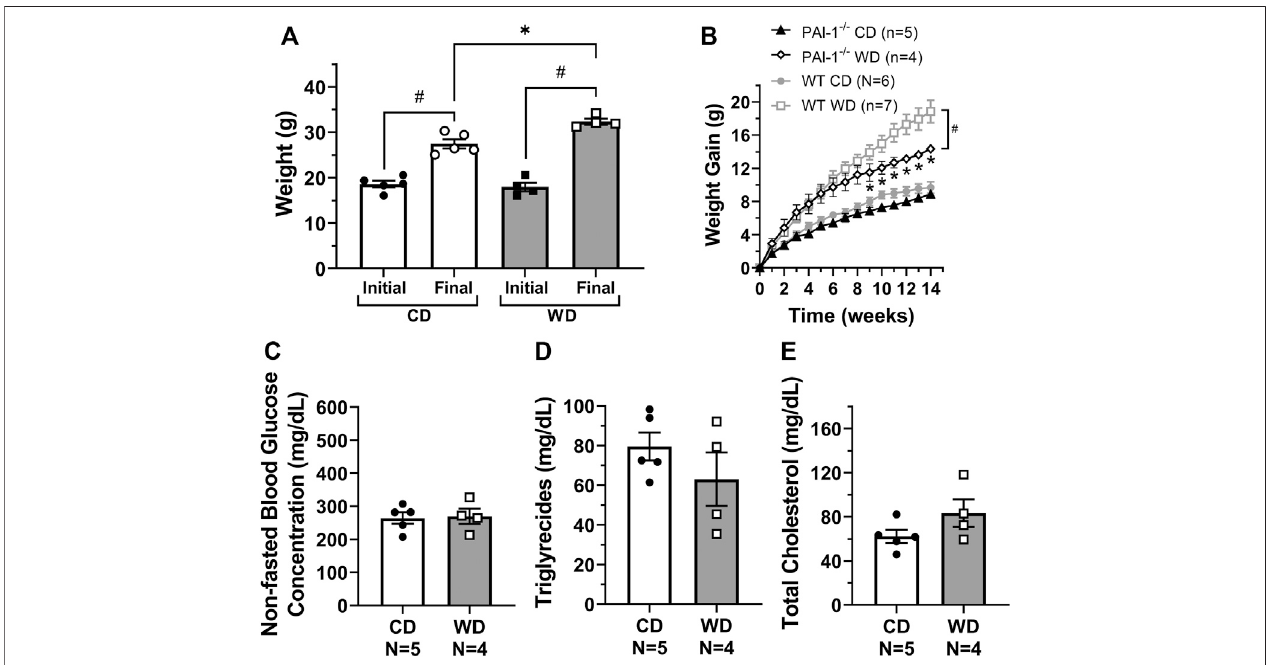
FIGURE 5 | Global PAI-1 de fi cient mice are partially protected against metabolic dysfunction. For PAI-1 − / − mice, (A) initial and fi nal body weight control diet (CD) and western diet (WD) groups; (B) overall gain in body weight per week over the 14-week treatment period (WT data from Figure 1B is also shown in gray); and (C – E) non-fasted plasma glucose, triglycerides, and total cholesterol concentration (in mg/dL) for CD and WD groups respectively. Data is presented as mean ± SEM. Statistically signi fi cant differences were evaluated using t tests for data in panels A, and C – E, and two-way ANOVA with Š ídák post hoc test for data in panel B. In panel A, # p < 0.05 for initial vs. fi nal weights; and in panel B, * p < 0.05 for CD vs. WD and # p < 0.05 for PAI-1 − / − WD vs. WT WD.